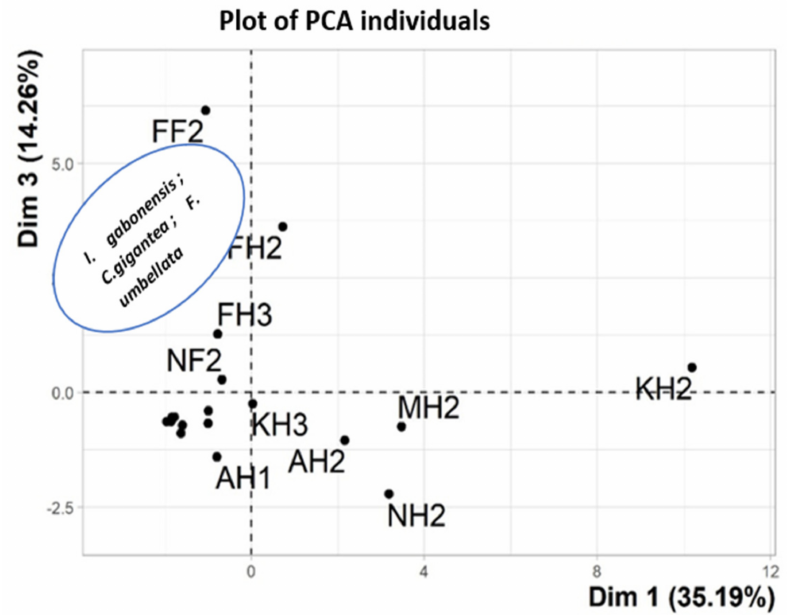
Figure 9. Projection of the different sociolinguistic groups in the axis system 1, 2, and 3. Legend: KH2: Kotafon man over 60; AH1: Adja man over 60; AH2: Adja man over 60; NH2: Nago man over 60;